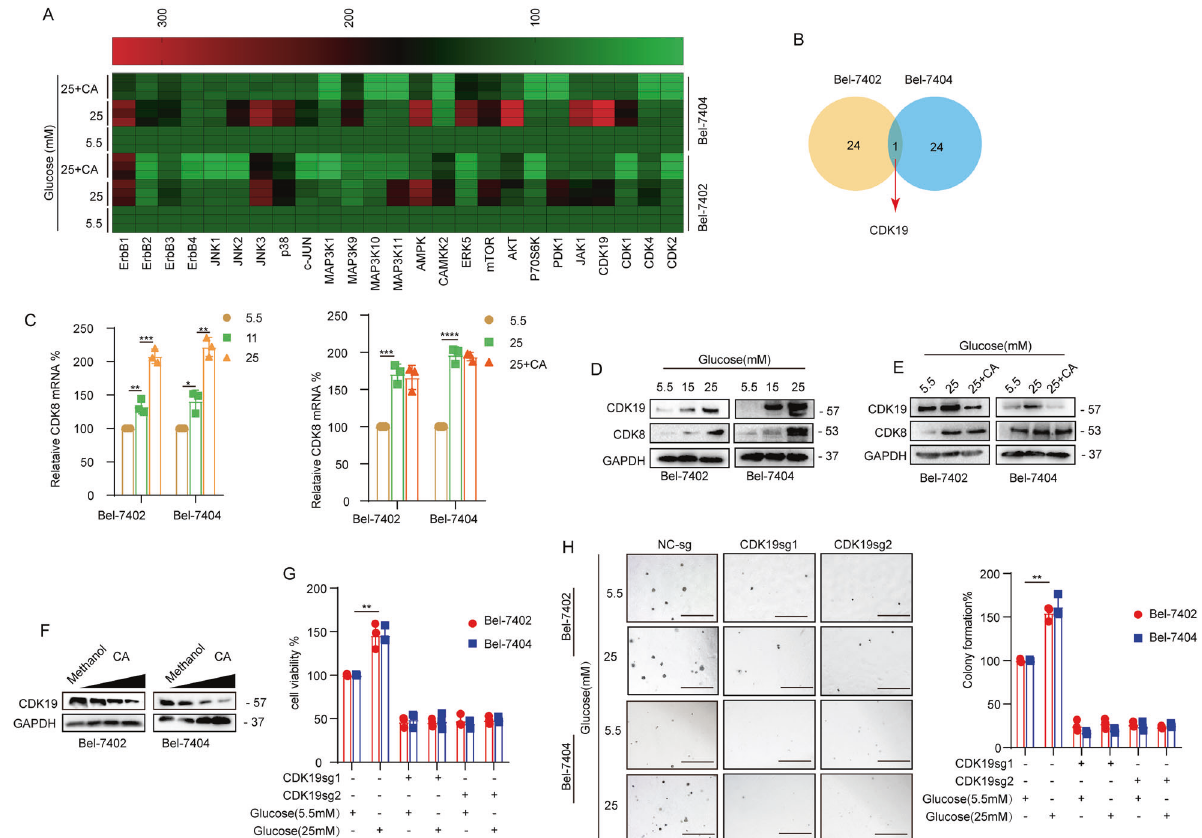
Fig. 4 A , B RT-qPCR assay detected the mRNA expression levels of 25 different kinases in Bel-7402 and Bel-7404 cells and detailed information on one overlapping gene. C CDK8 was analyzed by qPCR in Bel-7402 or Bel-7404 cells subjected to the indicated treatments. D , E CDK19 and CDK8 were analyzed by WB in Bel-7402 or Bel-7404 cells subjected to the indicated treatments. F Representative WB images of CDK19 in Bel- 7402 and Bel-7404 cells (transfected with 1 – 40 μ M CA). G , H Cell proliferation and colony-formation capacity were measured with CCK-8 cytotoxicity tests ( G ) and soft agar colony-formation assays ( H ), respectively, in Bel-7402 and Bel-7404 cells subjected to different treatments as indicated. Scale bar, 500 μ m. Data are shown as mean ± SD. * P < 0.05, ** P < 0.01, *** P < 0.001, **** P <